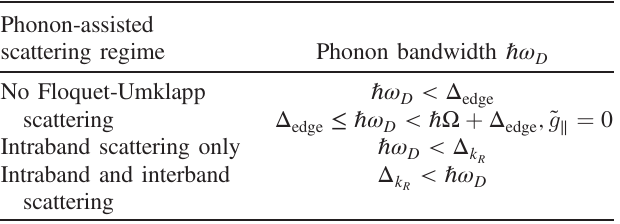
TABLE I. Summary of the different regimes of scattering processes assisted by acoustic phonons. Interband and Flo- quet-Umklapp processes are active or inactive depending on the relation between the phonon bandwidth ℏ ω and the relevant D Floquet gap: Δ is the Floquet gap at E ¼ 0 , while Δ is the k R edge Floquet gap at the Floquet zone edge E ¼ ℏ Ω = 2 . The drive parameter ~ g ∥ is defined through Eq.